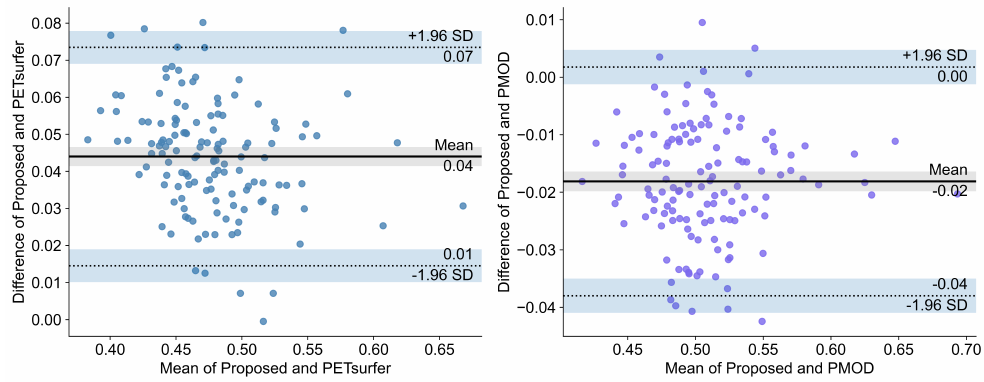
Figure 4. Bland–Altman plot of the proposed method, PETSurfer, and PMOD in the global region of amyloidosis-negative subjects.